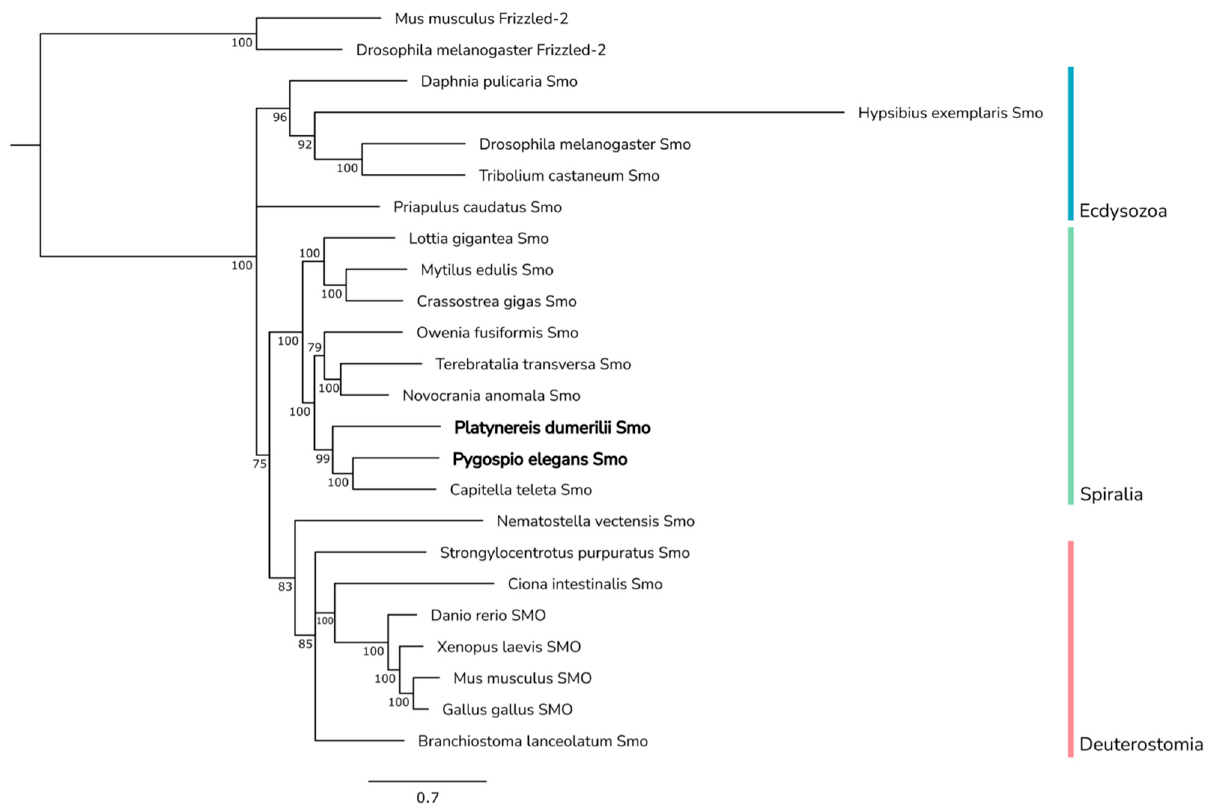
Figure 7. Phylogenetic analysis of Smo proteins. Bayesian phylogenetic analysis was performed using an amino acid alignment of conserved N-terminal regions of metazoan Smo proteins. Pele-Smo and Pdum-Smo, along with Capitella Smo, clustered into the Annelida group within the monophyletic Spiralia clade. Smo proteins from deuterostomes and Nematostella Smo joined into a separate clade. Ecdysozoan Smo proteins formed a basal branch in the tree. Numbers near branch nodes indicate Bayesian posterior probabilities. Bayesian posterior probability values less than 75 are not shown.